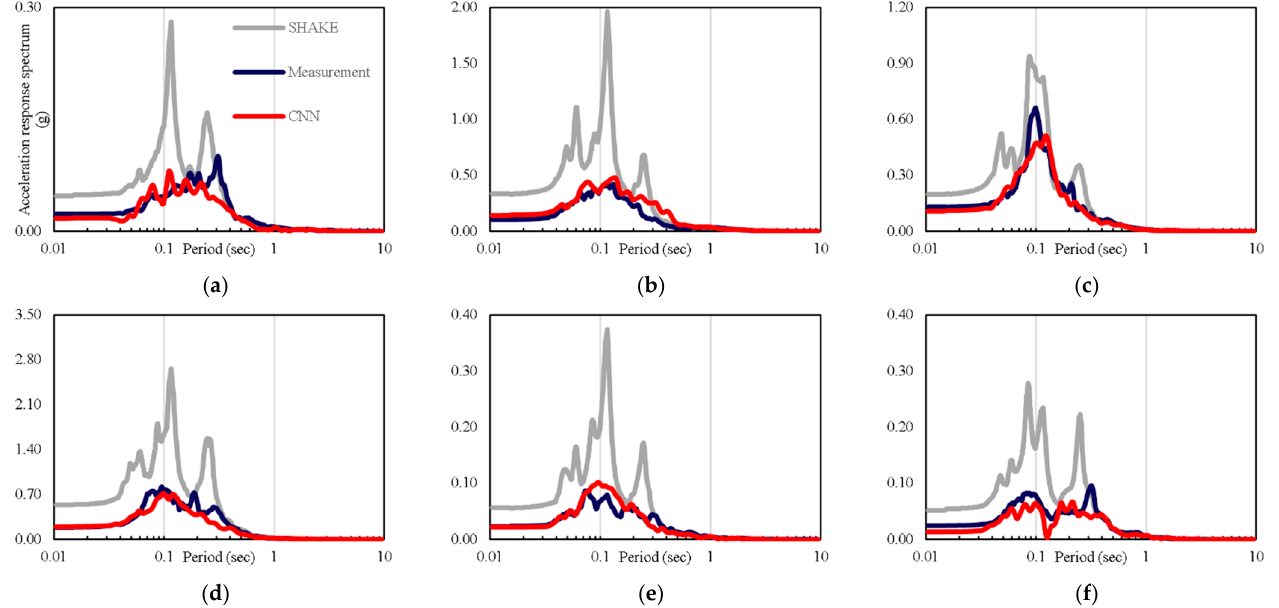
Figure 15. The six samples of acceleration response spectra measurements and predictions at site IWTH05. ( a )